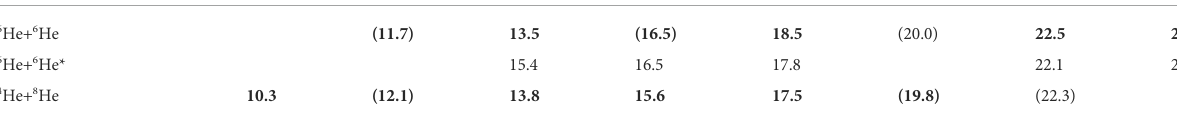
fi rst excited state at 1.8 MeV and with J π = 2 + , is observed for the fi rst time in this work. Two of the observed fi ve states in this decay channel most likely correspond to the states decaying